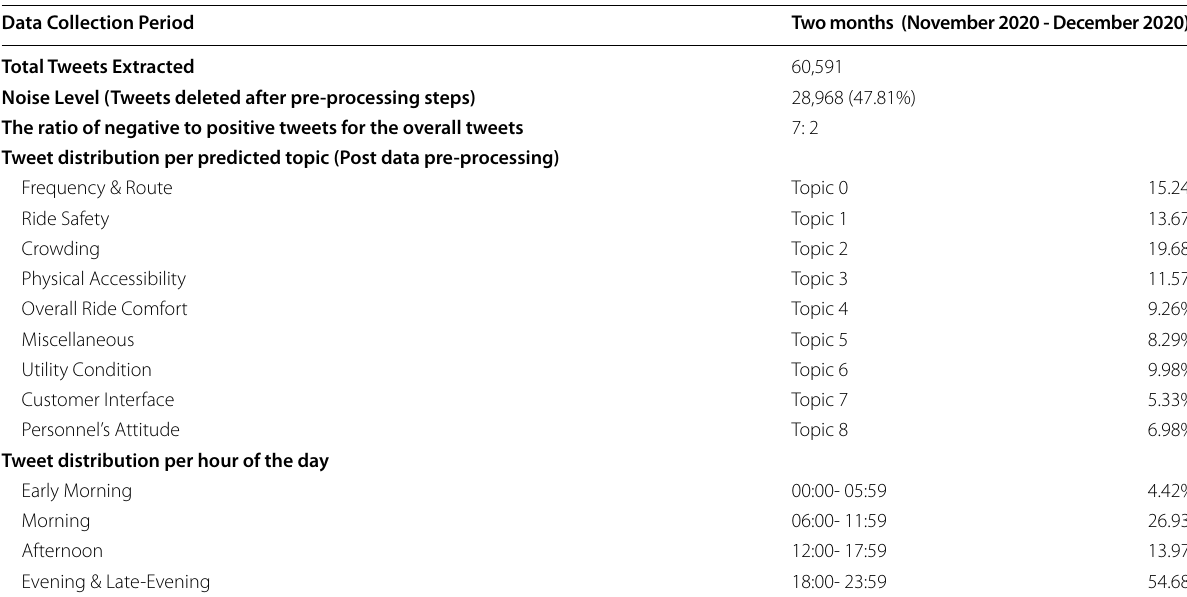
Table 2 Dataset